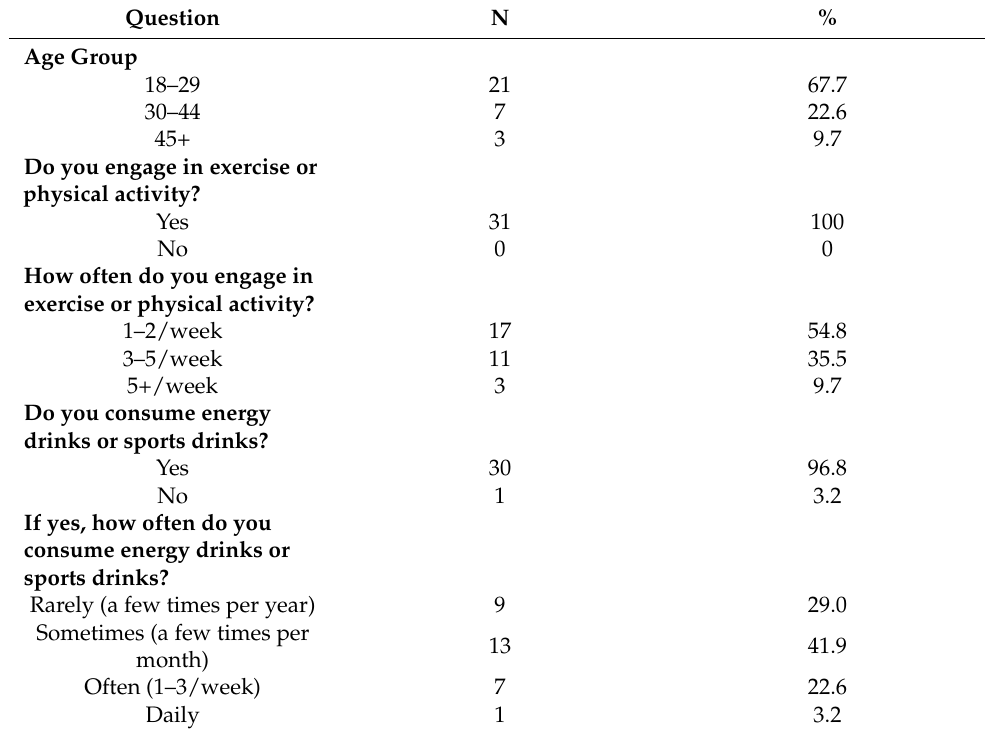
Table 4. Questionnaire